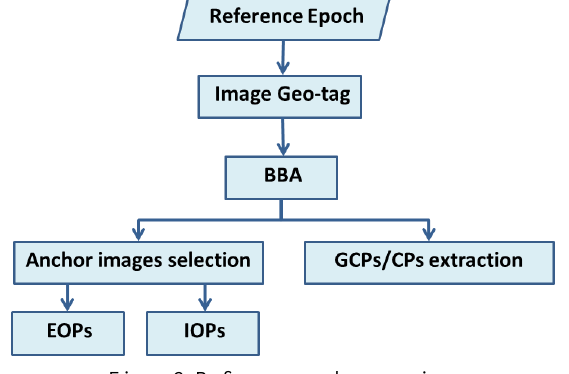
Figure 2. Reference epoch processing.